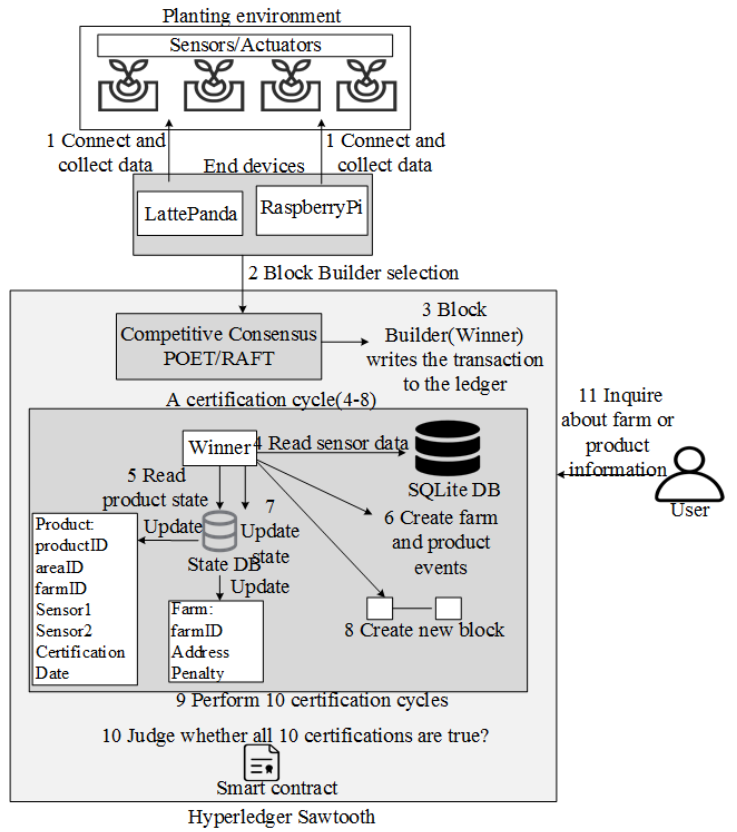
Figure 20. Reconstruction diagram of reference [45].